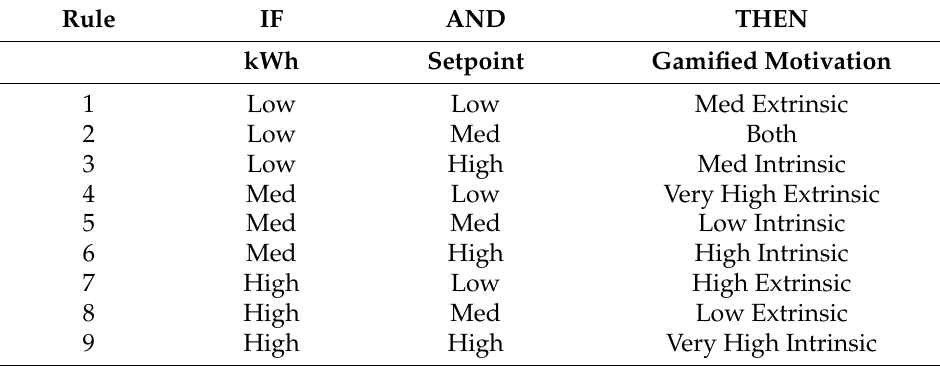
Table 6. Fuzzy logic inference rules for summer period.